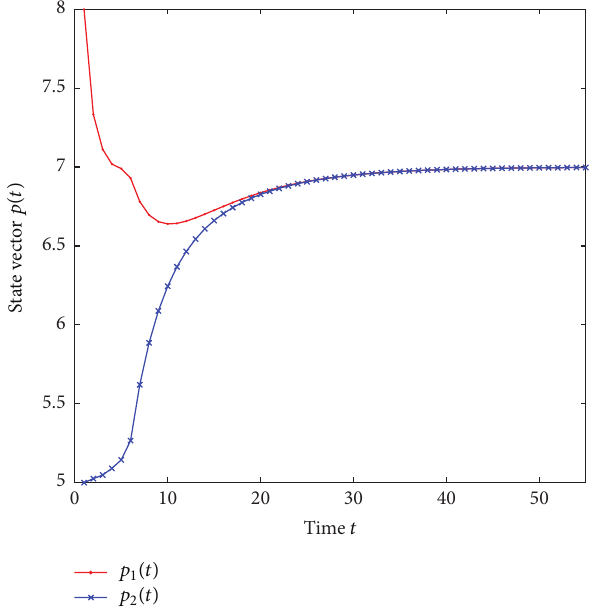
Figure 4: The state vector of system (30) with 𝑞 0 = [5,8] 𝑇 ∉ 𝑋